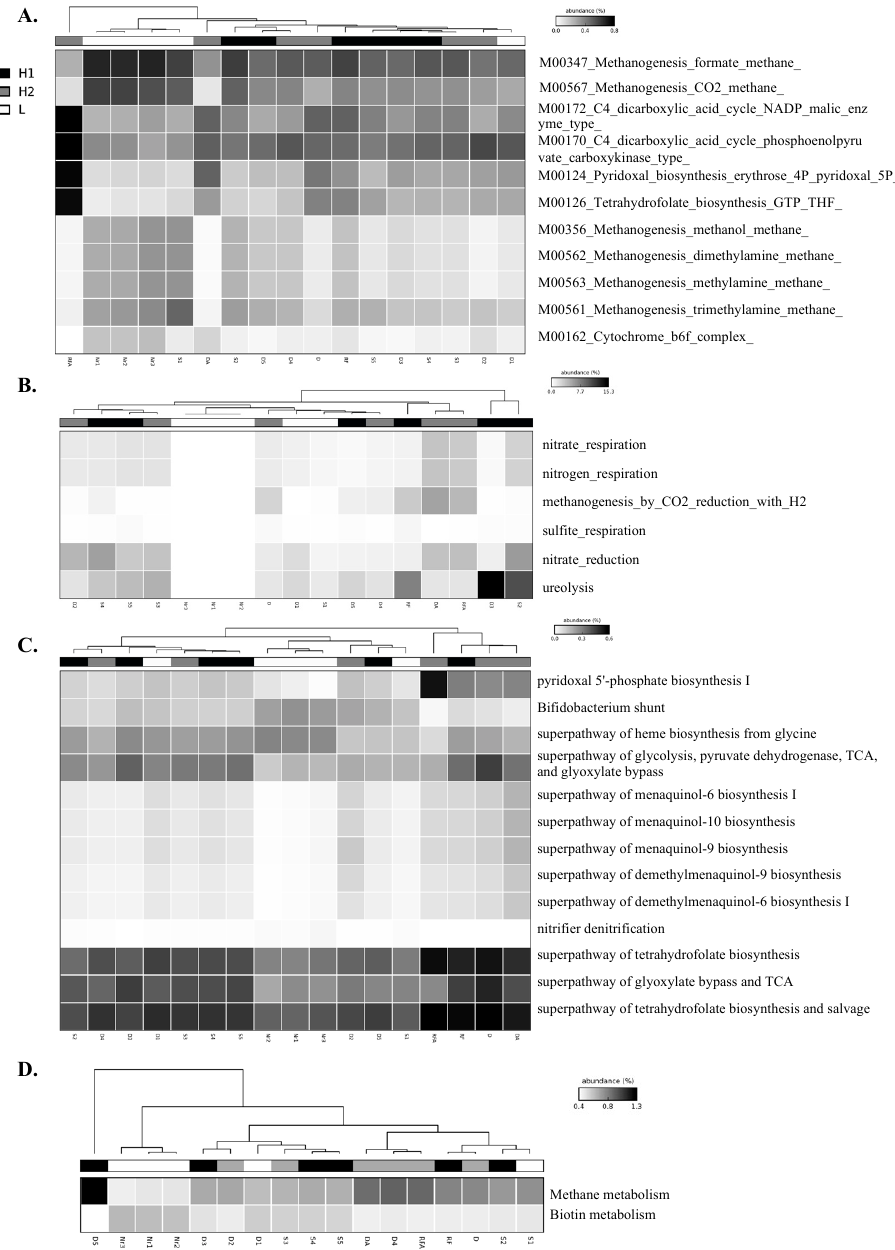
Figure 2. Heatmap of functional features related to energy metabolism and cofactor, carrier, and vitamin biosynthesis metabolism predicted by A . BugBase. B . FAPROTAX. C . PICRUSt2. D . Tax4Fun2. The abundance scale bar represents the percentage with grayscale. H1 represents the voltage outputs of soils larger than 50 mV (D3, D5, S2, S4, S5 and RF) with black. H2 represents the voltage outputs of the soils lower than 50 mV (D2, D4, S3, D, DA and RFA) with gray. L represents the soils without MFC processing (D1, S1, Nr1, Nr2 and Nr3) with white.